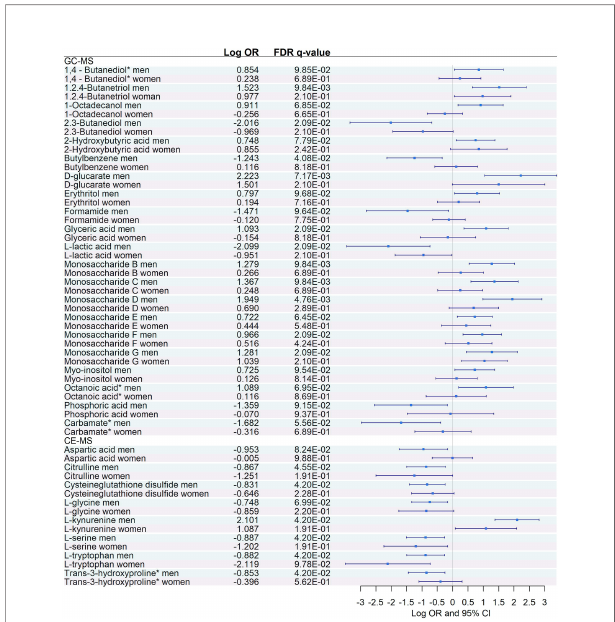
FIGURE 8 | Sex-speci fi c pairwise comparisons between Severe vs. Moderate patients in GC-MS and CE-MS metabolites Logistic regression, adjusted for age, was used for each sex separately. The False Discovery Rate or FDR was used to cope with multiple testing, q -values are provided. 1,4-Butanediol*, (R*,S*)- 3,8-Dioxa-2,9-disiladecane, 2,2,9,9-tetramethyl- 5,6-bis[(trimethylsilyl)oxy]. Carbamate*, Tris(trimethylsilyl)carbamate. Trans- 3-hydroxyproline*, trans-3-hydroxyproline/trans-4-hydroxyproline/cis-4-